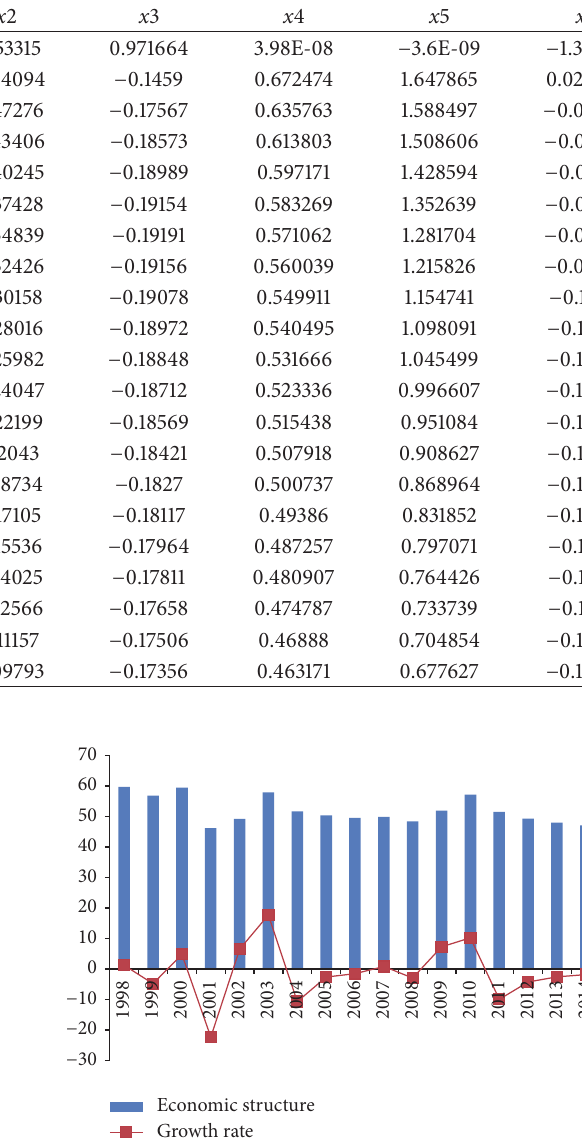
Figure 5: Energy consumption structure in China from 1998 to 2014 (%) and the growth rate (%). Figure 6: Economic structure in China from 1998 to 2014 (%) and the growth rate